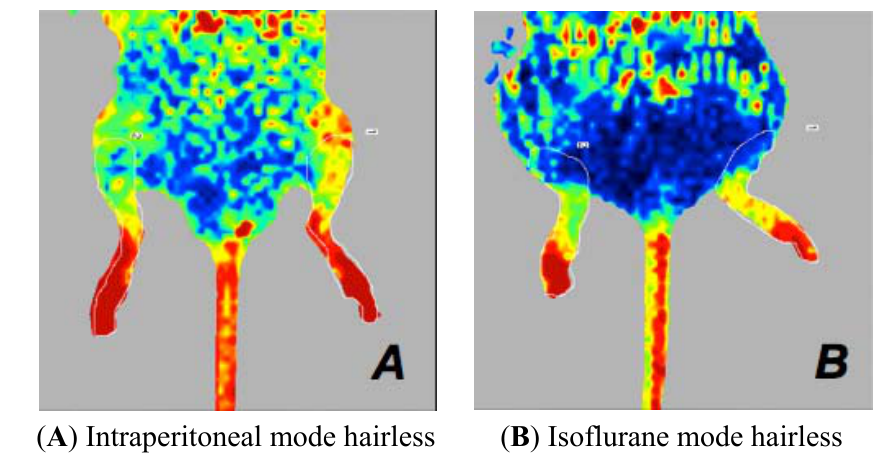
Figure 5. Laser Doppler images of the hind limbs of mice. Perfusion signal is associated with the type of anaesthesia when the mouse is placed in dorsal recumbency. The mice have a body temperature of 38 °C and ARD depilation (A,B). In this experimental condition, mice anaesthetised with intraperitoneal drugs ( A ) have perfusion values higher than mice anaesthetised with isoflurane ( B